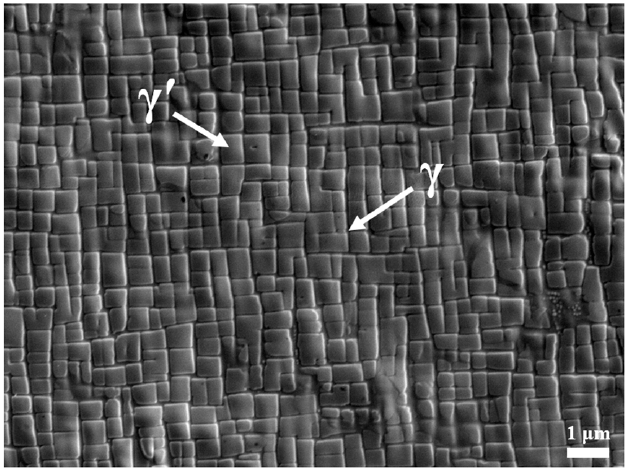
Figure 1. SEM image showing the microstructure of test sample.